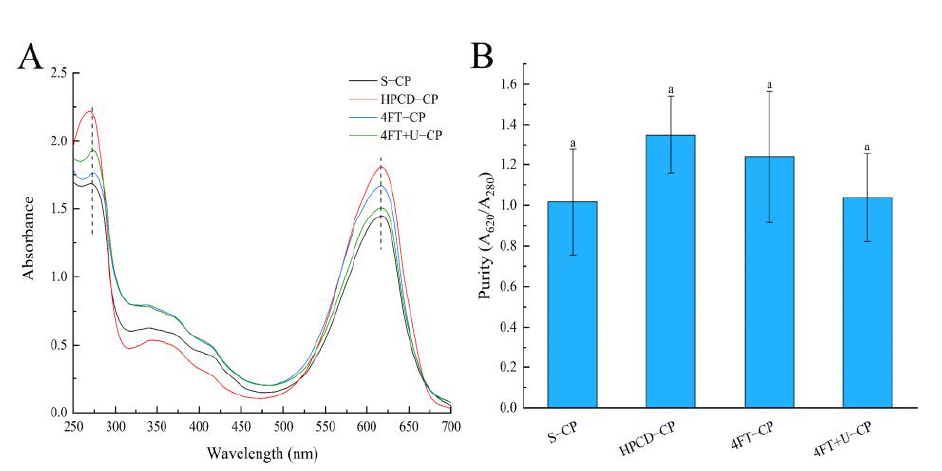
Figure 1. Absorption spectra ( A ), CP purities ( B ), color analysis ( C ), and zeta potential ( D ) of CPs obtained by different extraction methods. Different lowercase letters or single asterisks indicate sig- nificant differences ( p < 0.05).